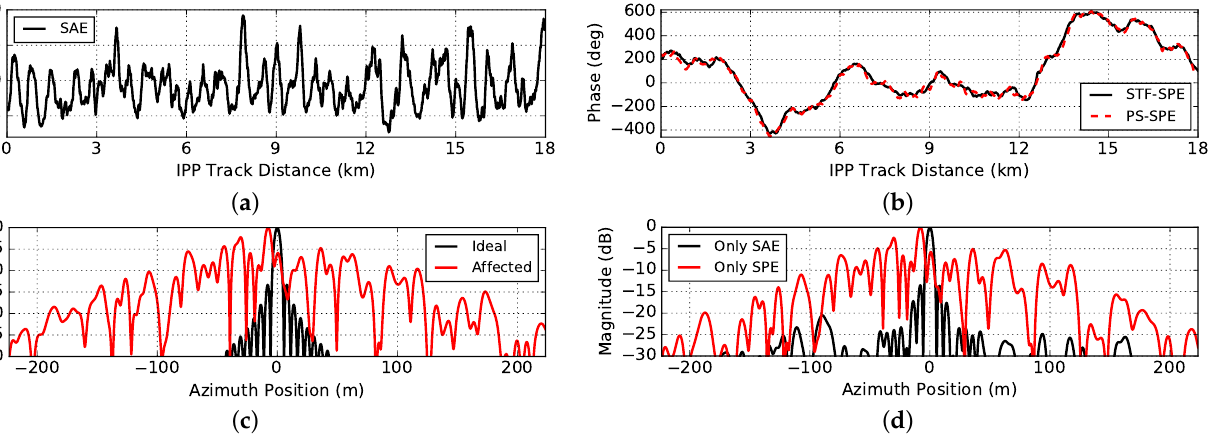
Figure 2. Scintillation effects on the P-band SAR azimuth-imaging performance. ( a ) the two-way STF-SAE; ( b ) the two-way STF-SPE (black) and PS-SPE (red); ( c ) the ideal (black) and affected (red) azimuth profiles; ( d ) affected profiles by only SAE (black) and by only SPE